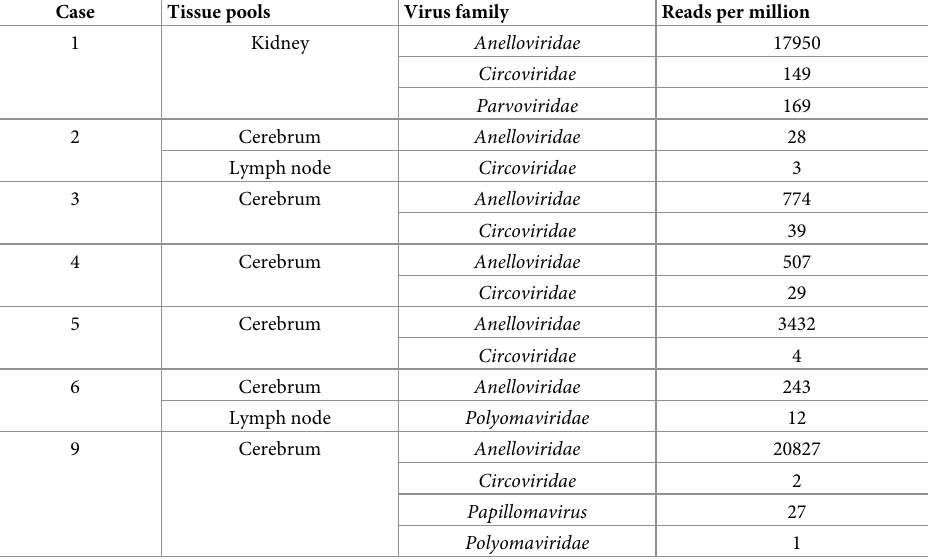
Table 2. Viruses detected by metagenomics